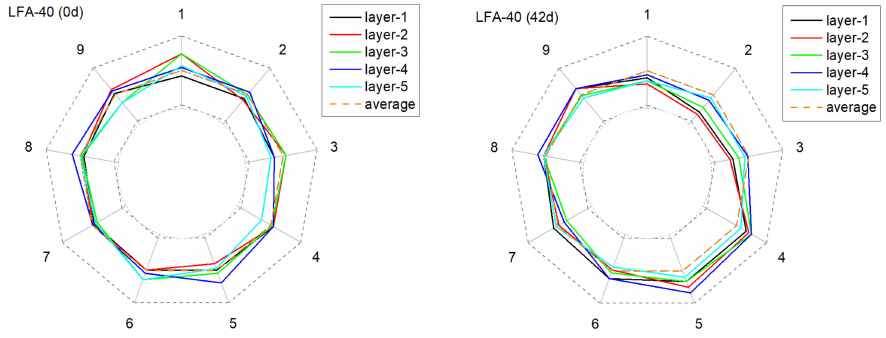
Figure 12. The deviation of the current from the mean value of current over time at different positions in the anode sample during the AAT (LFA-40).